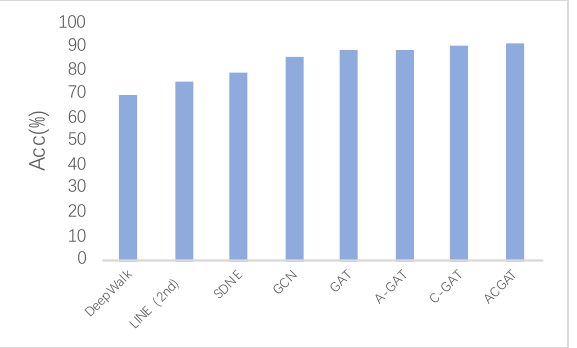
Figure 10. Classification results for